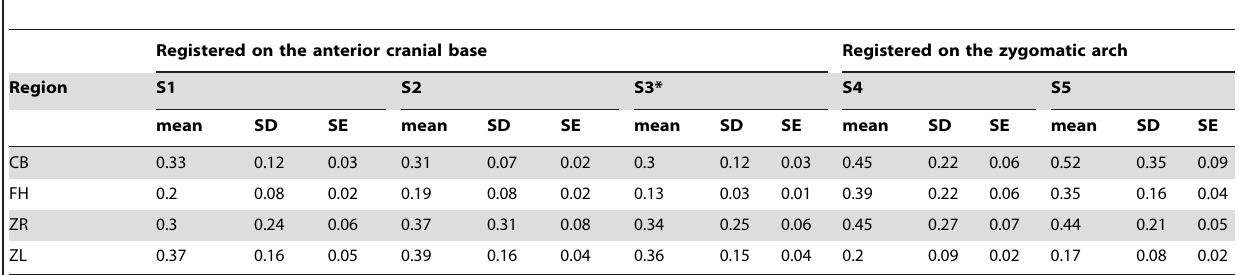
Table 1. Mean distances (mm) between the superimposed models measured at 4 different regions following 5 repeated